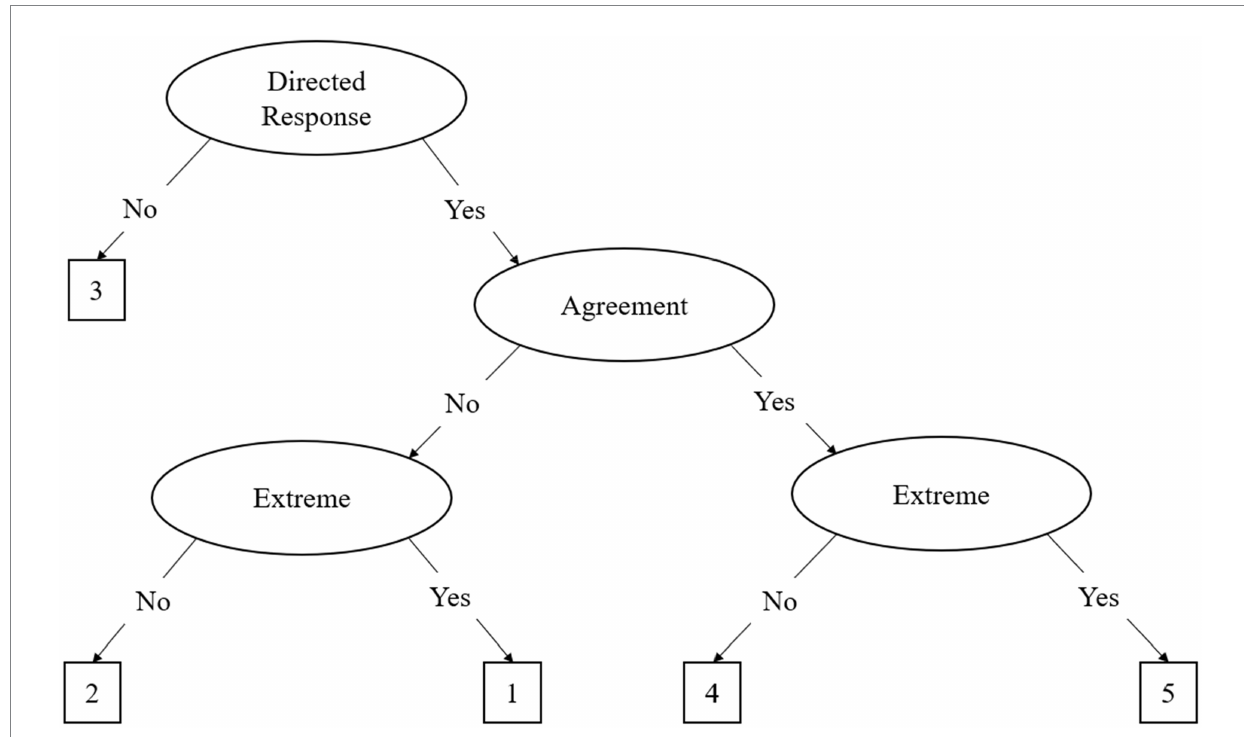
FIGURE 1 The Midpoint Primary Process (MPP) Decision Hierarchy Model. This figure assumes a “1” to “5” Likert scale for response options.